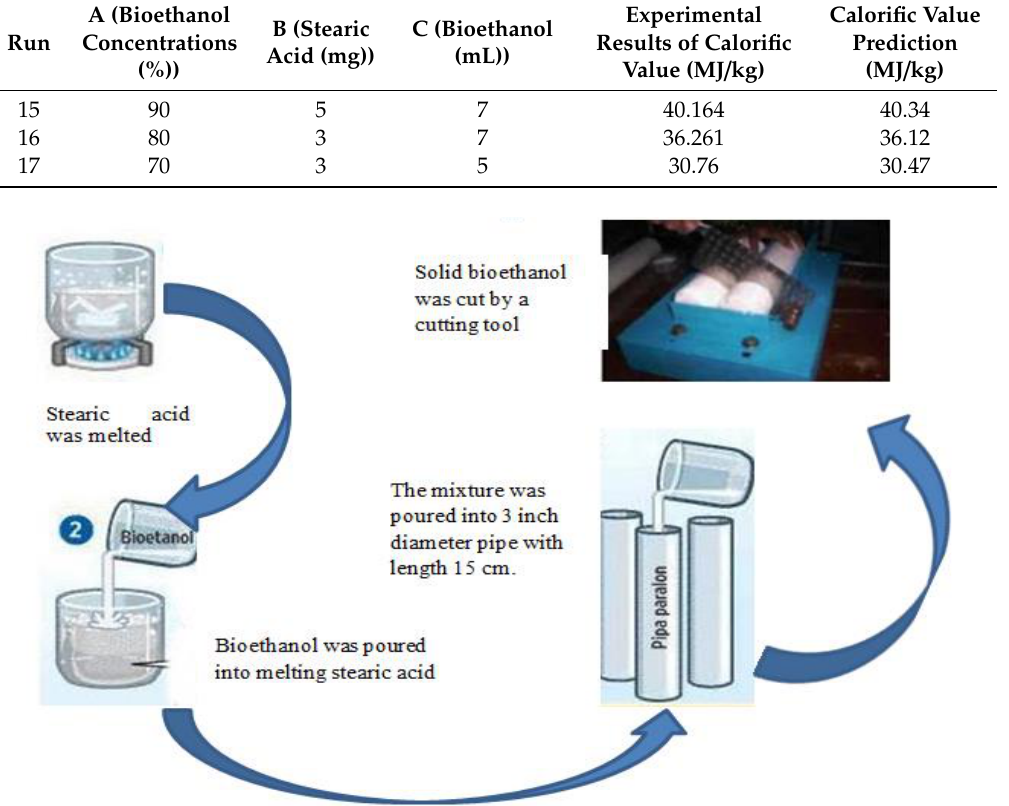
Figure 1. Solid bioethanol production by mixing bioethanol and stearic